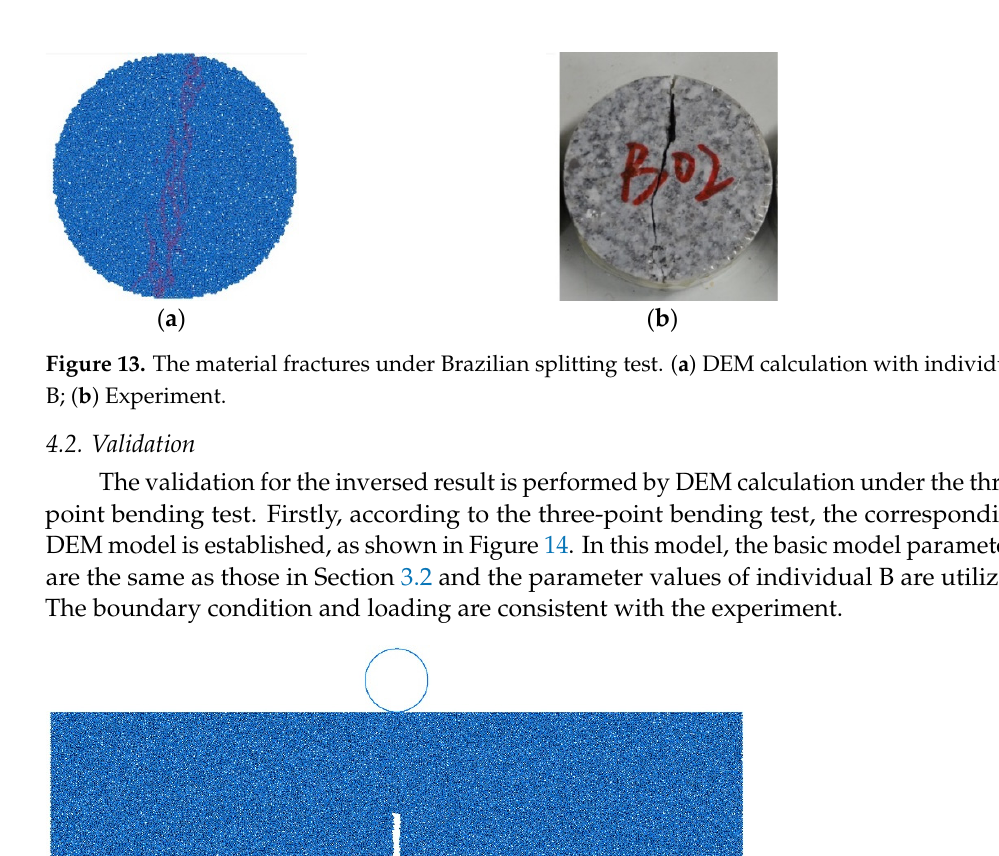
Figure 12. The material fractures under uniaxial compressive test. ( a ) DEM calculation with indi- vidual B; ( b ) Experiment.